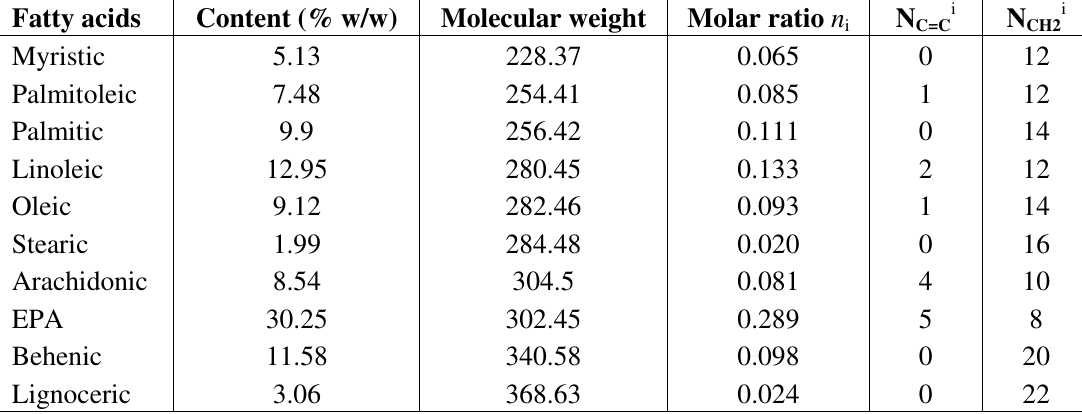
/N of the mixture C=C CH2